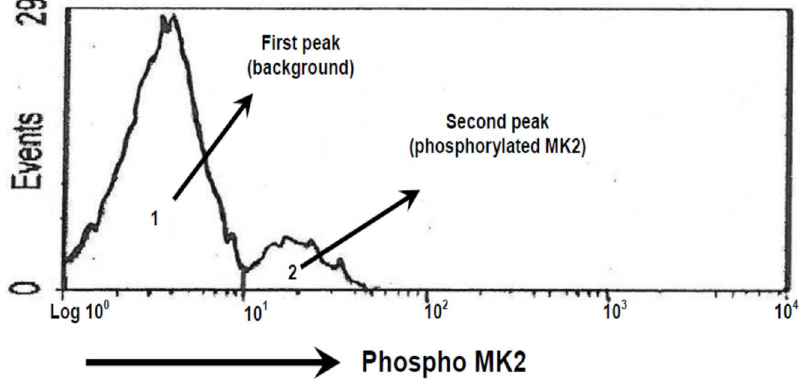
Figure 2. Area of Phosphorylated MK2.